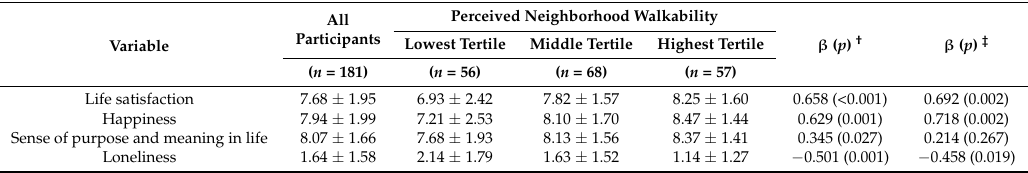
Table 4. Crude and adjusted associations of perceived neighborhood walkability * with measures of wellbeing and loneliness ( n =